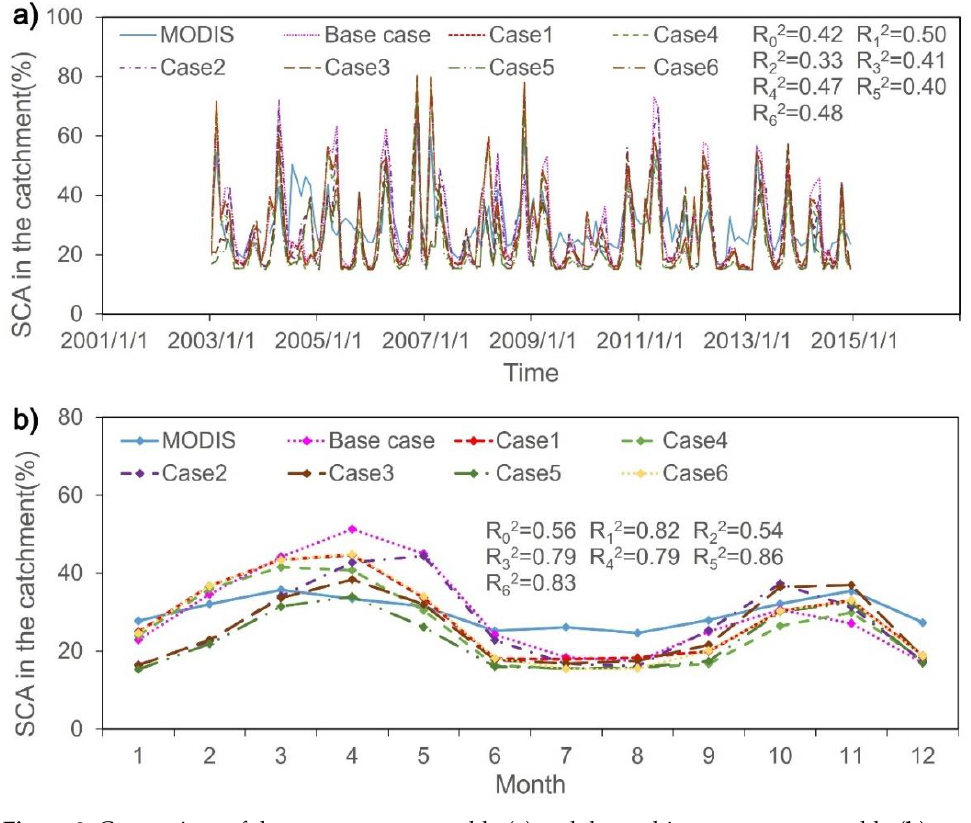
Figure 9. Comparison of the year-to-year monthly ( a ) and the multiyear-average monthly ( b ) snow cover area (SCA) simulated from the seven cases.